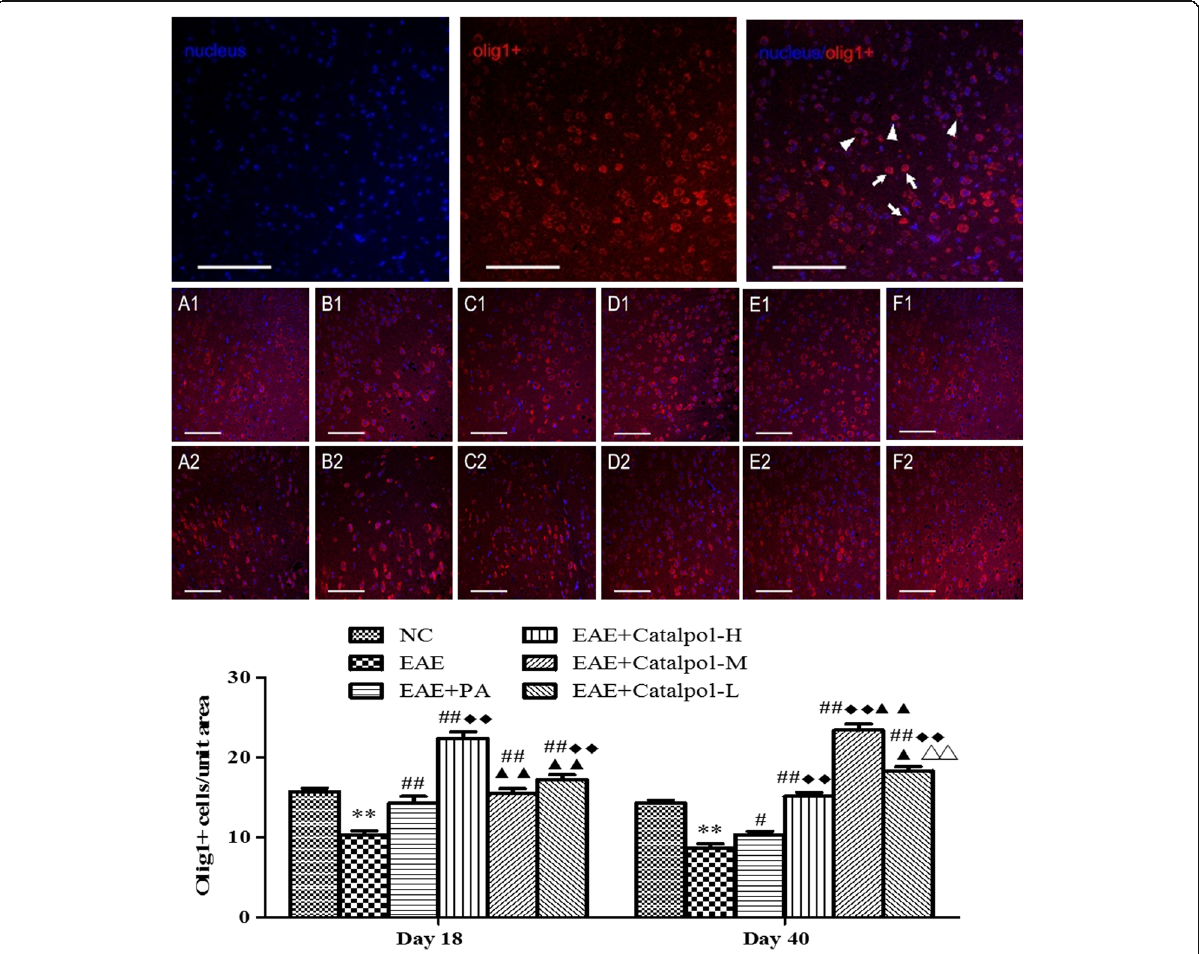
Fig. 8 Confocal images in the cortex of mice labeled with nucleus (blue) and Olig1 (red). Olig1 was located in nuclear of cells (arrows) and was also present in cytoplasm (arrowheads). A1 to F1 and A2 to F2 show the Olig1+ in the brains of mice on Day 18 and Day 40 in NC ( n =4), EAE ( n =4), EAE+ PA ( n =4), EAE+Catalpol – H ( n =4), M ( n =4) and L ( n =4), respectively (scale bar 100 μ m). The protein expressions of Olig1 in the brains of mice were analyzed. Note: ** P <0.01 vs. NC, ## P <0.01 vs. EAE; ◆◆ P <0.01 vs. EAE+ PA; ▲ P <0.05, ▲▲ P <0.01 vs. EAE+Catalpol – H; △△ P <0.01 vs. EAE+Catalpol –